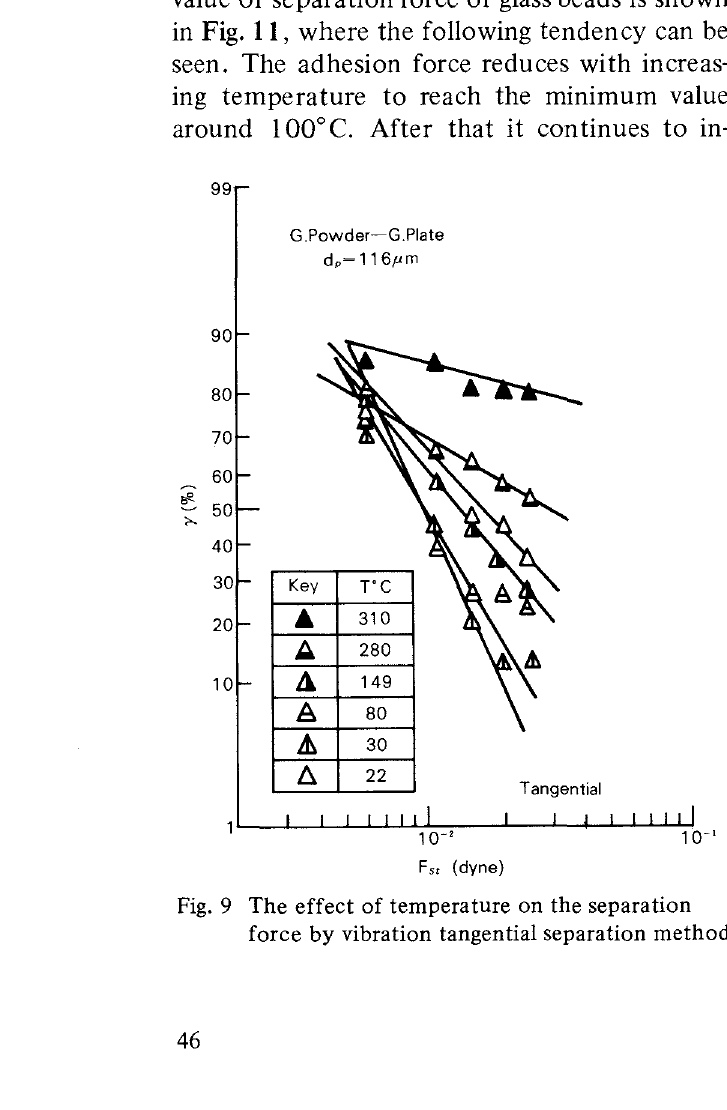
Fig. 9 The effect of temperature on the separation force by vibration tangential separation method